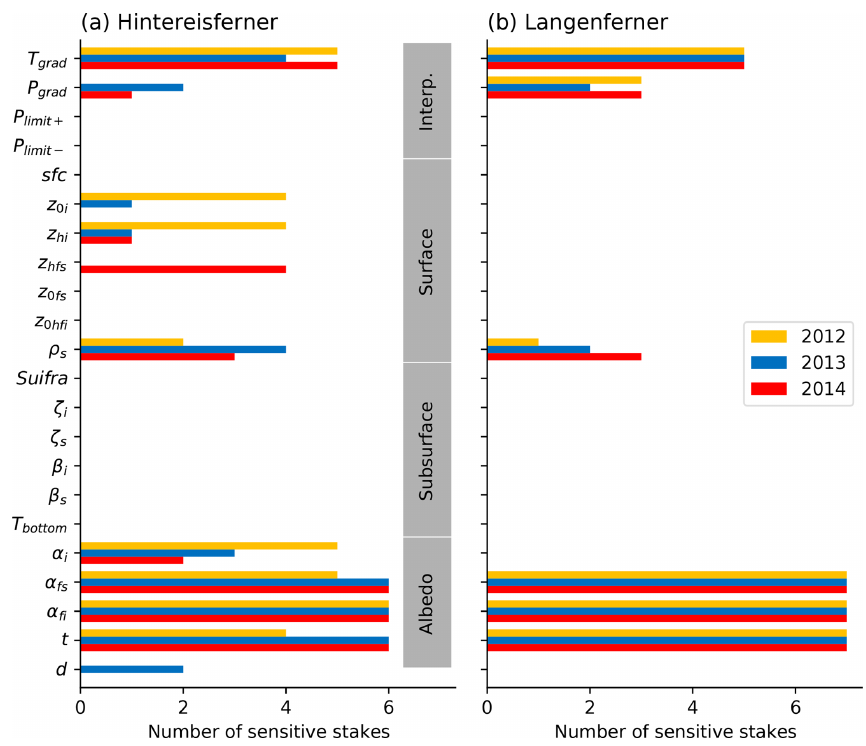
Figure 4. The amount of sensitive stakes per year for (a) HEF and (b) LGF. The sensitivity analysis was performed at seven stakes on each glacier, though the vertical gradients can only be tested at six stakes as one is located at the same altitude as the reference weather station. Every parameter with a sensitivity index higher than 0.05 got a score of 1, giving a maximum count of seven per year (meaning the model is sensitive to this parameter at all stakes). Parameters involved in the parameterization of surface albedo are dominating, with snow related parameters in the upper section of the glacier and ice related ones at the lower stakes. Hintereisferner shows a total of 11 sensitive parameters and Langenferner